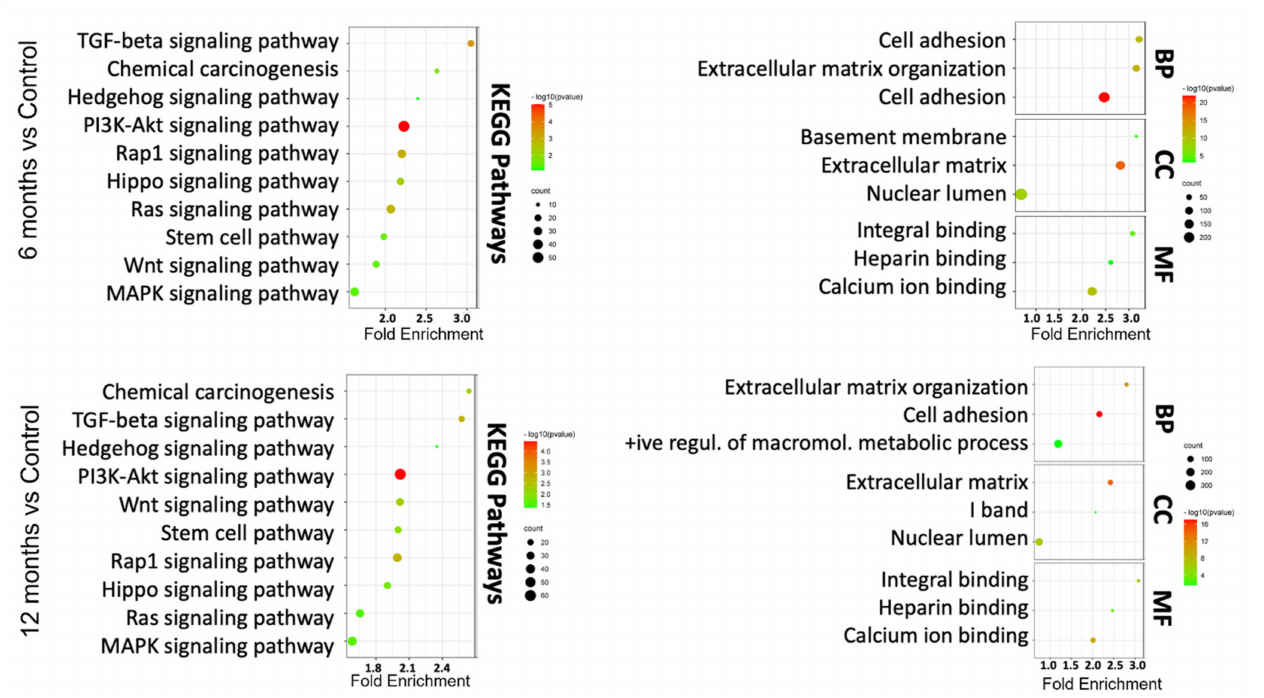
Figure 3. KEGG pathway and GO term analysis of differentially expressed genes based on RNA-seq data for 6-month and 12-month As-exposed cells compared to control cells. Each bubble’s color and size correspond to the amount of differentially expressed mRNAs enriched in GO or KEGG pathway, respectively. The cut-off for choosing to GO and KEGG keywords was p <